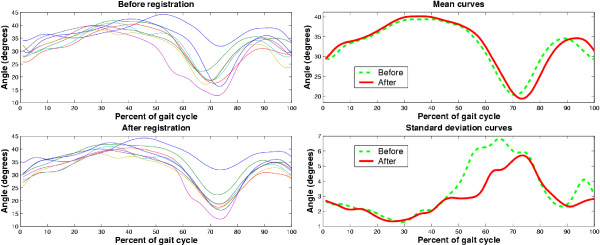
Accounting for phase variation. On the left, we portray unregistered (top graph) and registered (bottom graph) ankle angle curves from a child with spastic diplegia. On the right are the mean (top) and standard deviation (bottom) curves before (dashed line) and after (solid line) curve registration.